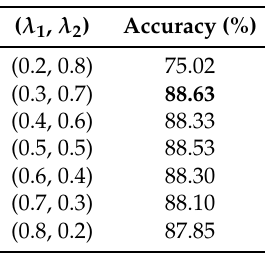
Table 3. The recognition accuracy (%) with different ( λ 1 , λ 2 ) settings.